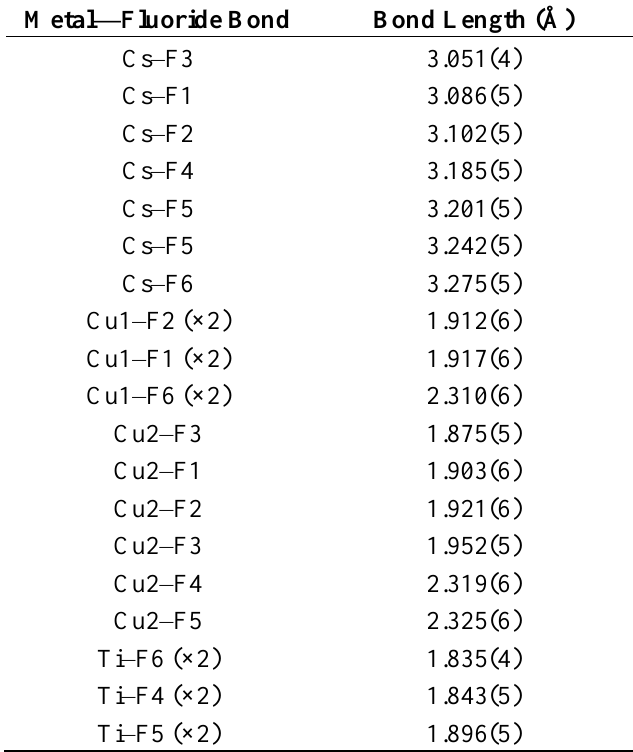
Figure 4. A selection of SXPD reflections for Cs 2 TiCu 3 F 12 at 300 K. Note the broadening of the (0,0,9) reflection compared to (2,1,4), indicative of an anisotropy in crystallite shape. Table 4. Selected metal-fluoride distances for Cs 2 TiCu 3 F 12 at 100 K as derived from SXPD data ( P 2 1 / n